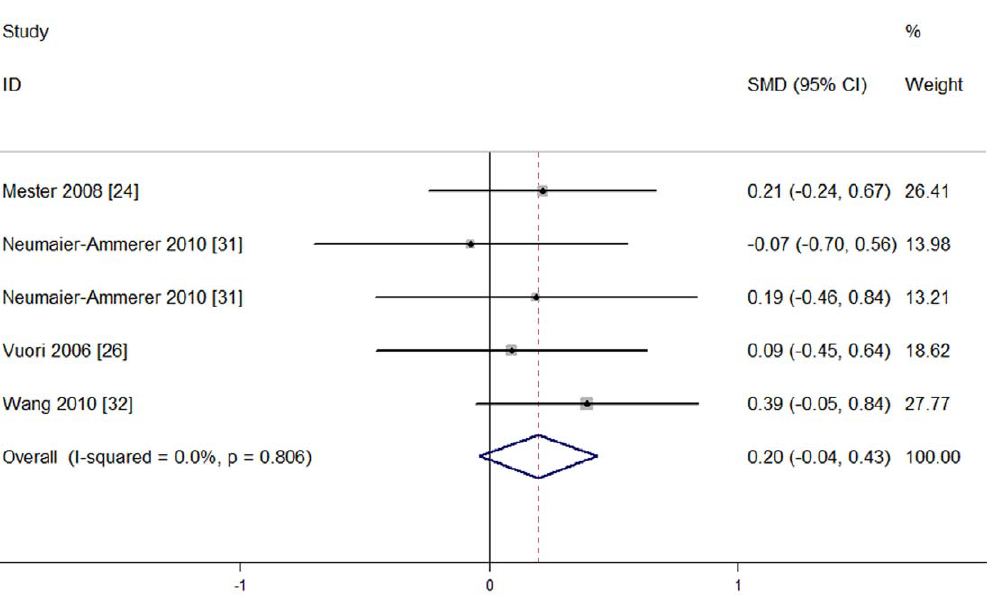
Figure 6. Meta-analysis of postoperative color vision in the blue light spectrum under photopic light condition.